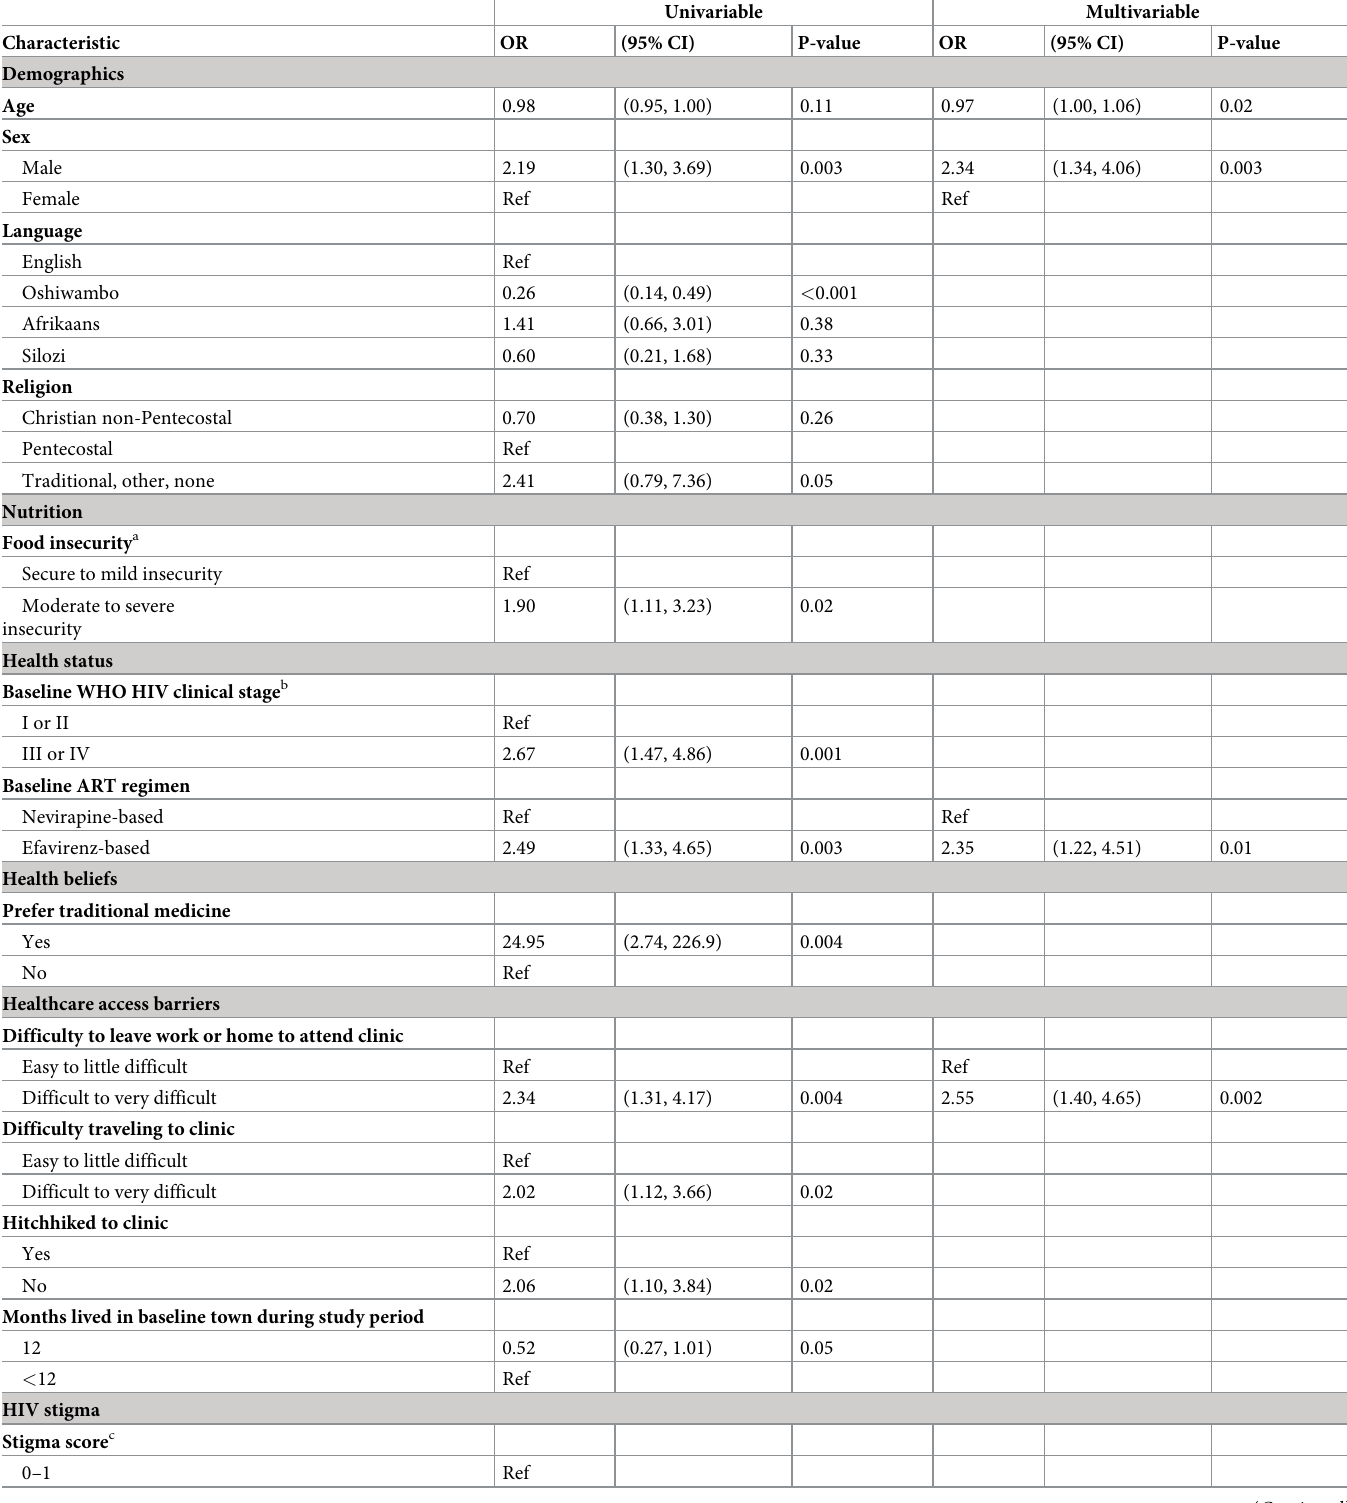
Table 2. Characteristics associated with LTFU in univariable and multivariable